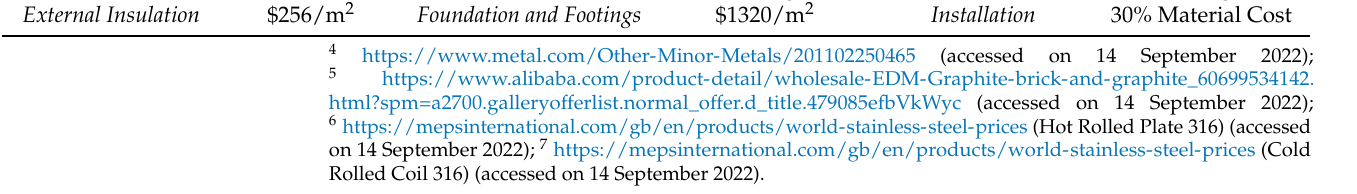
Table 4. Design specifications of the hybrid TES system.